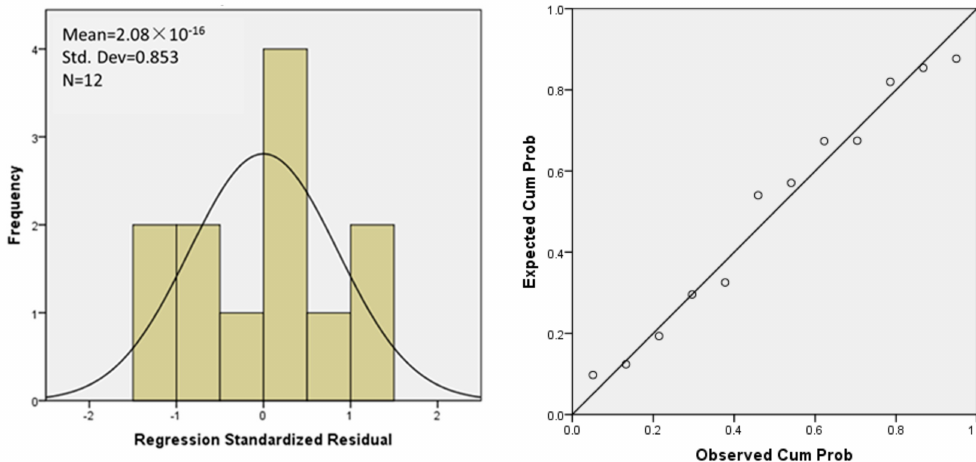
Figure 5. Residual analysis results for debris flow initiation time T vs. flow rate Q , slope S and the vertical grading coefficient Ψ .